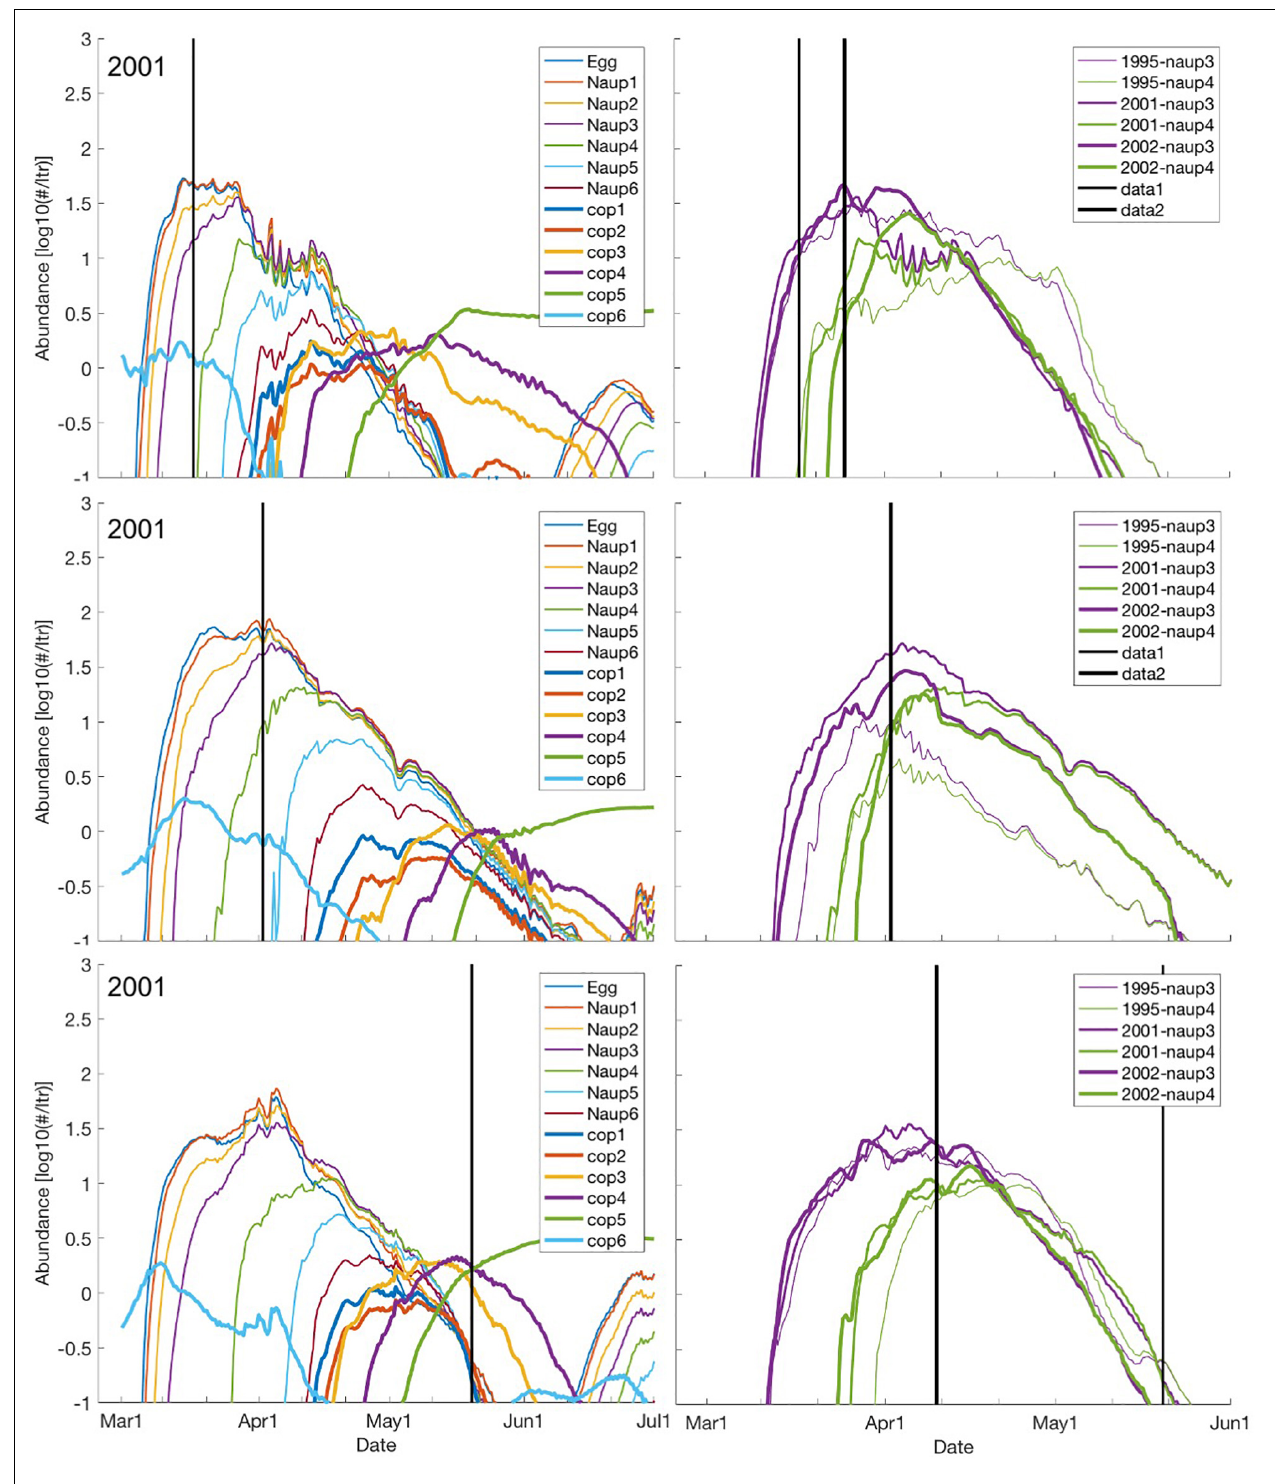
FIGURE 4 | Abundance at each nauplii and copepod stages for the SGs 2, 5, and 8 (upper, mid, and lower panels) during March through June for 2001 (left panels) when distributing C. finmarchicus across a 10 m water column. The vertical lines indicate time of spring bloom onset according to remote sensing data (Vikebø et al., 2019). Corresponding abundances for nauplii stages 3 and 4 but for the years 1995, 2001, and 2002 (right panels). Note that the SeaWIFS or MODIS data used here do not cover 1995, the onset of spring bloom inferred from the remote sensing data is concurrent for 2001 and 2002 at SG 5 and that the onset of spring bloom is suspiciously late at SG 8 in 2001 likely due to a combination of few data points at the narrow shelf and